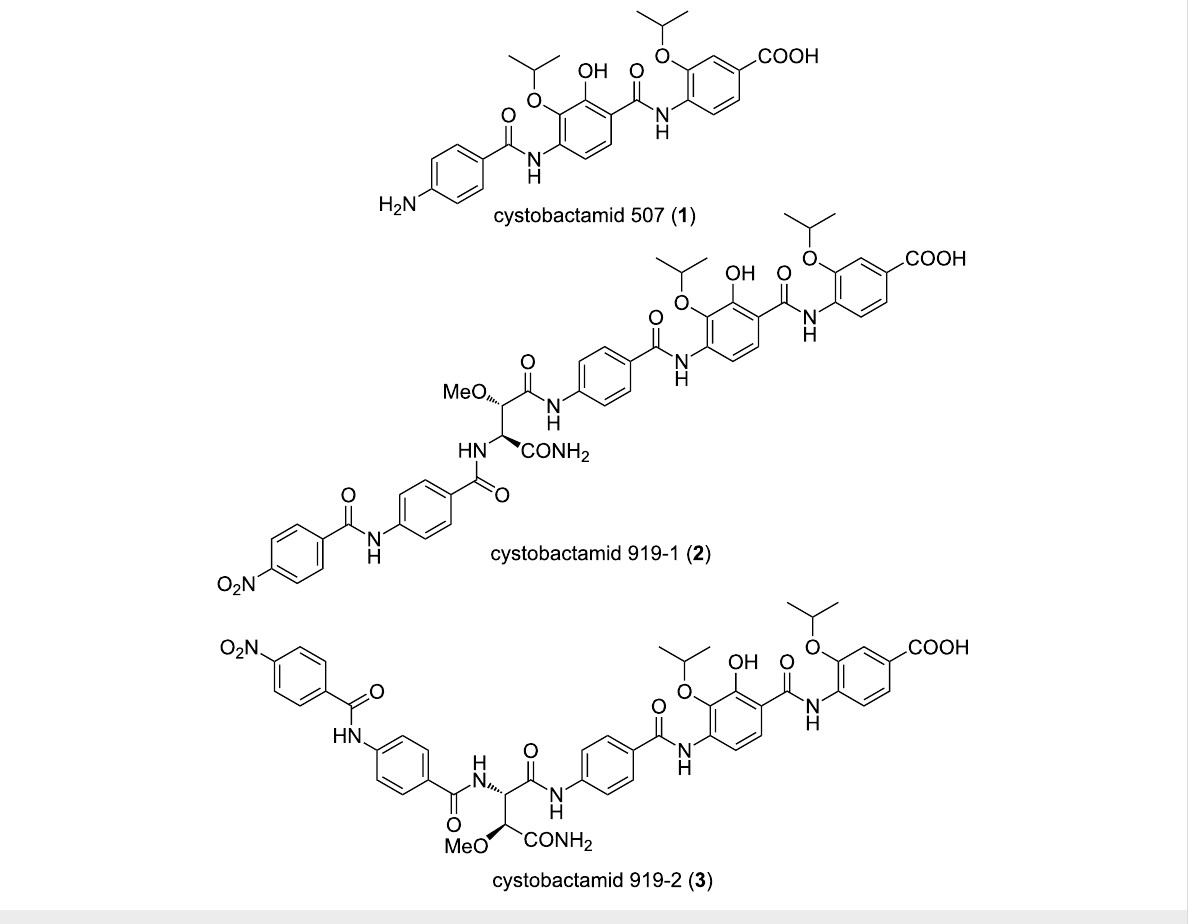
Figure 1: Structures of cystobactamids 507, 919-1 and 919-2.